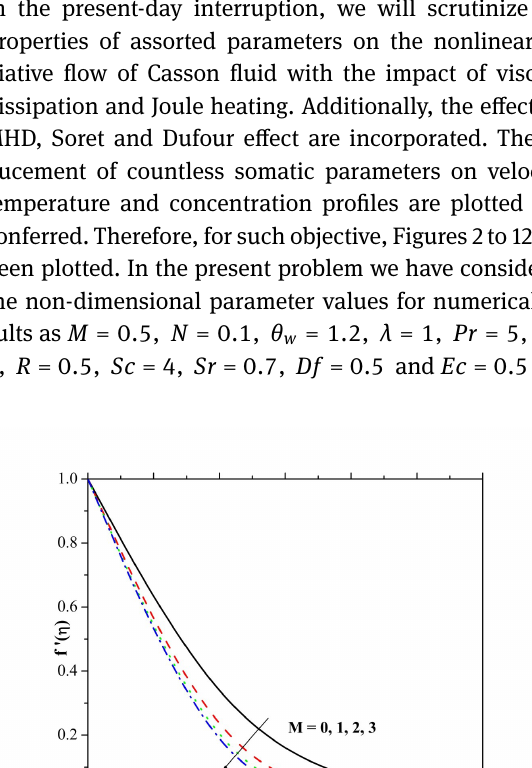
Fig. 4: Influence of λ on f ′ ( η ) .